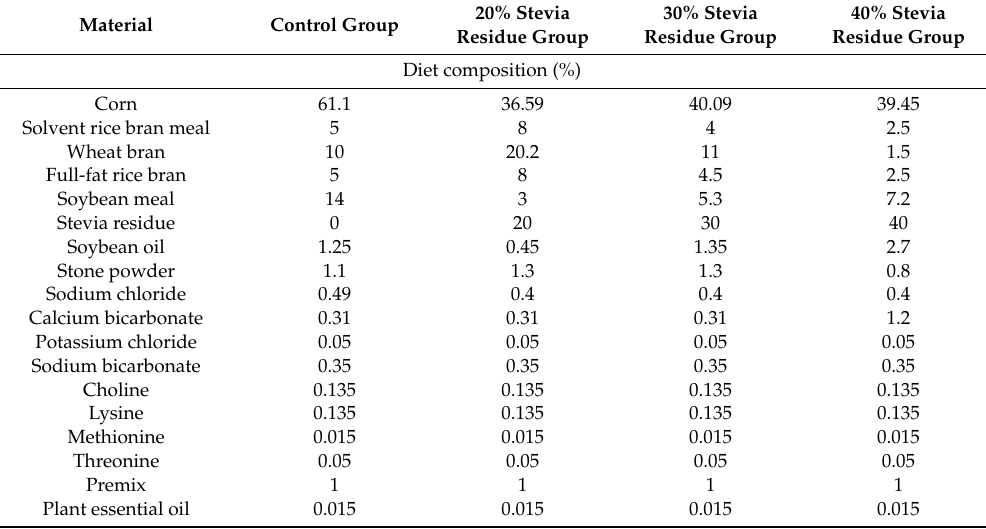
Table 3. Diet composition and nutrition level (air-dried basis,